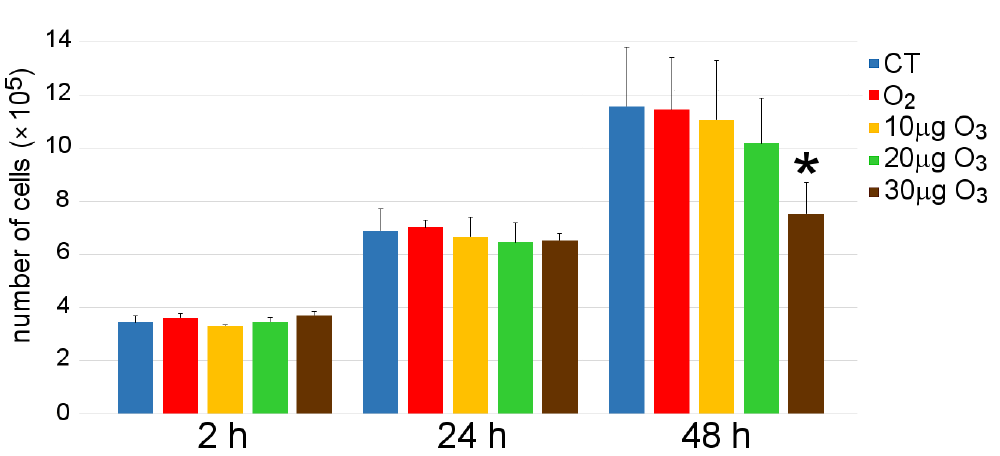
Figure 8. Diagrams show the mean value ± SD of the number of viable PHA/PMA activated-Jurkat cells after 2 h, 24 h, and 48 h from gas treatment. The asterisk (*) indicates significant difference with the respective control (CT).